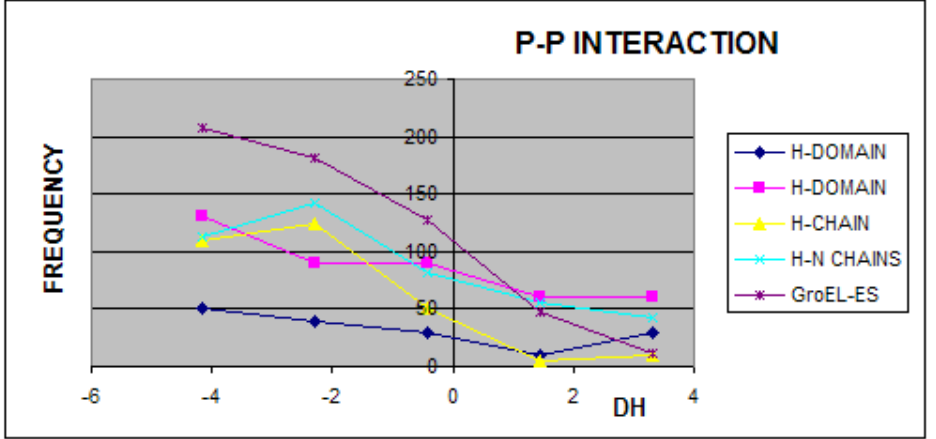
~ Δ of residues in the chain H engaged in protein- ~ Δ are characteristic for this type of interaction.